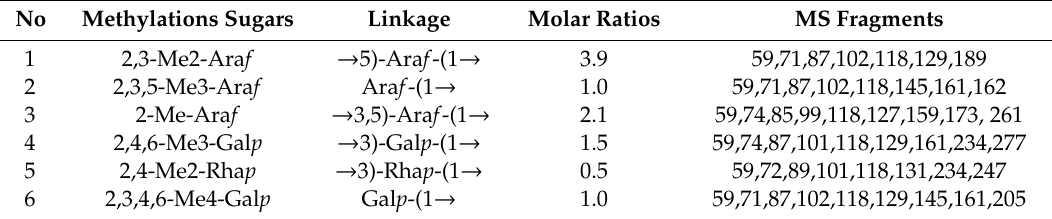
Table 1. Alditol acetate derivatives from the methylated JC-PS1